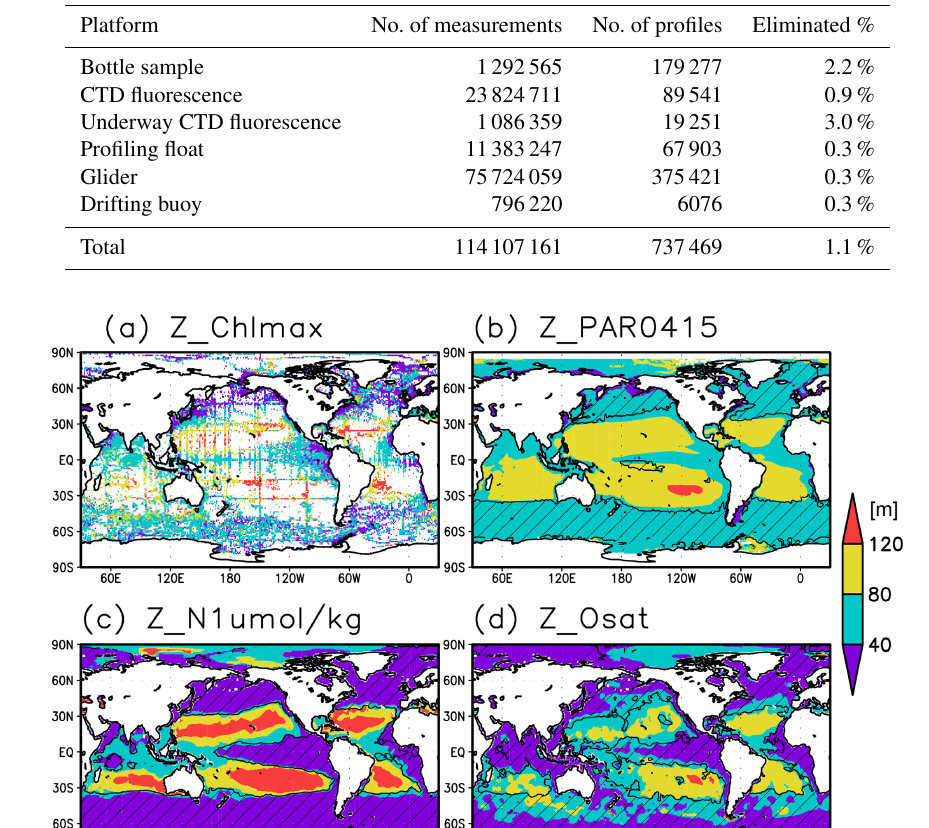
Table 1. Number of chlorophyll a (Chl a ) measurements and profiles from each data source with percentages eliminated by quality control.